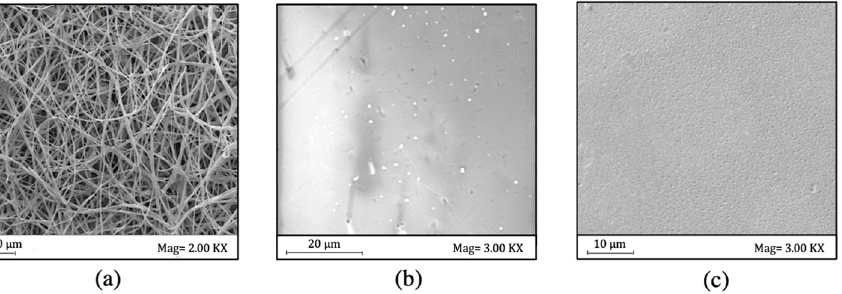
Figure 3. ( a ) SEM image of the fibrous structure obtained by the unloaded electrospun mat, ( b ) and ( c ) SEM images of the continuous structure obtained by the unloaded casted and spin coated sam- ples, respectively.